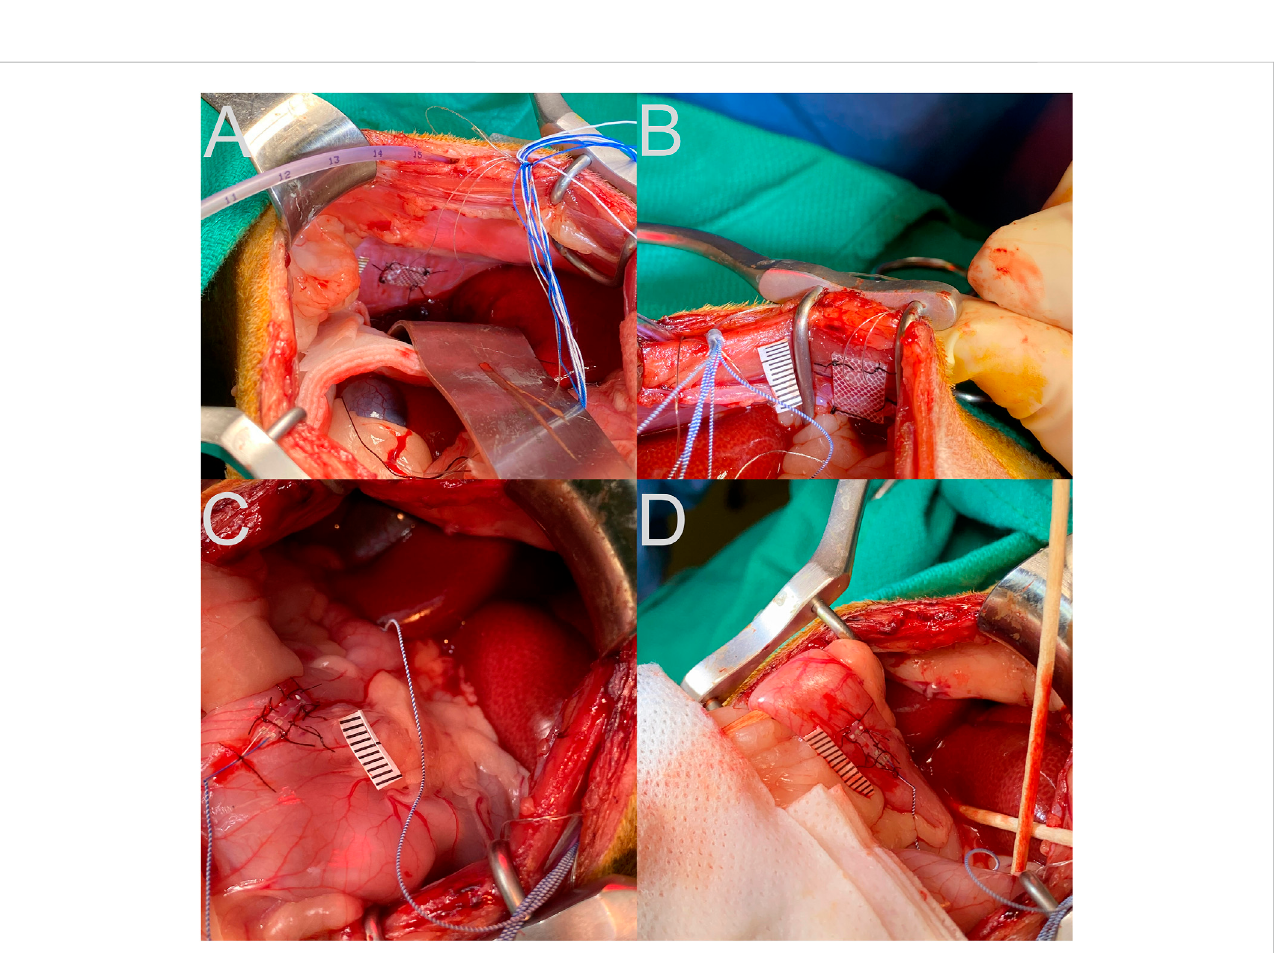
FIGURE 1 Placement of recording electrodes on the diaphragm (A) , abdominal musculature (B) , stomach antrum (C) , and upper duodenum (D) . A ruler with 1 mm hatch marks is placed next to the electrode in each panel.